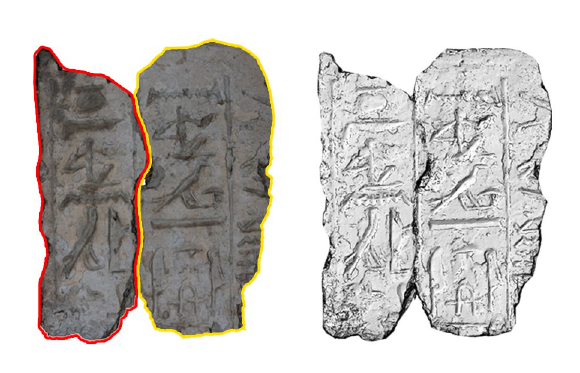
Figure 5 . Enhanced readability of two reliefs, digitally recomposed. On the left the digital orthophoto, on the right the enhanced view using ridges filter and Lambertian 45°